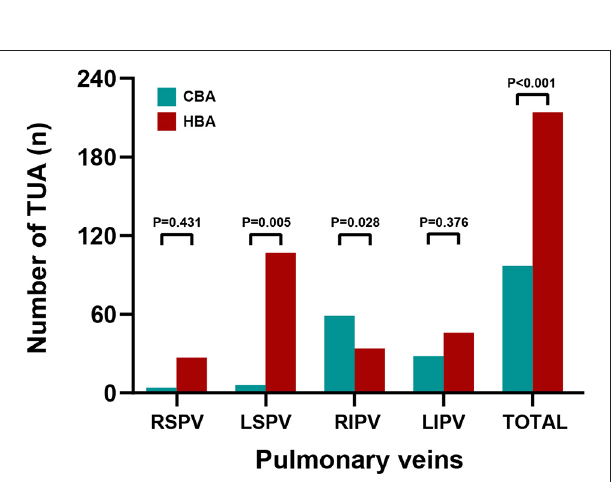
FIGURE 3 | Diagram showing the touch-up ablation incidence of cryoballoon ablation and hot balloon ablation. A noticeable increase in the incidence of ablation was observed in the HBA group ( P < 0.001). More touch-up ablations were applied in the RSPV, LSPV, and LIPV in patients with HBA. More ablations were performed in the RIPV in patients with CBA. Statistical significance was set at P < 0.05. CBA, cryoballoon ablation; HBA, hot balloon ablation; LIPV, left inferior pulmonary vein; LSPV, left superior pulmonary vein; RIPV, right inferior pulmonary vein; RSPV, right superior pulmonary